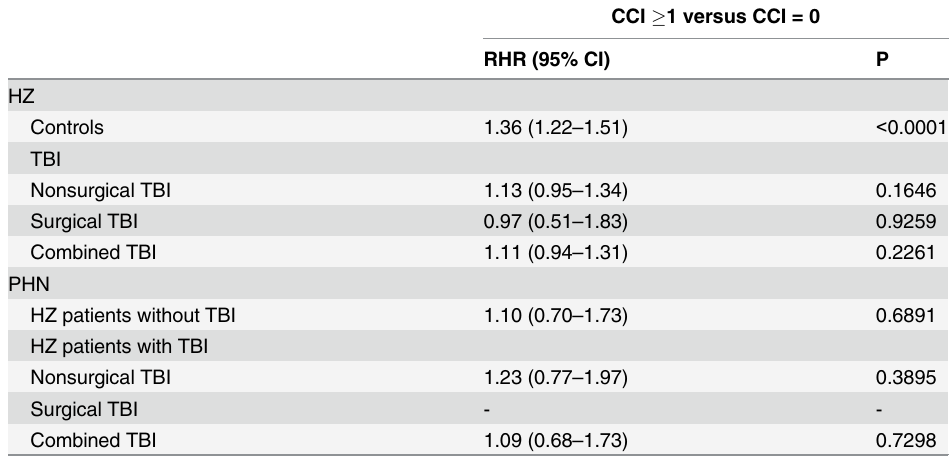
Table 6. Ratios of hazard ratio for herpes zoster and postherpetic neuralgia for adult patients with a Charlson comorbidity index (CCI) (cid:1) 1 versus a CCI = 0.